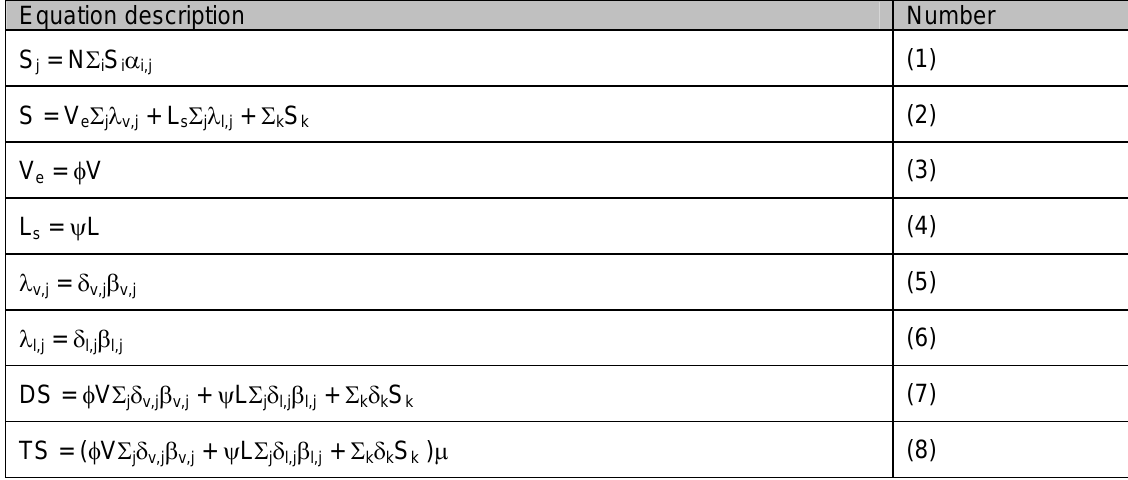
Table 1: System of equations for estimating local economic impact Equation